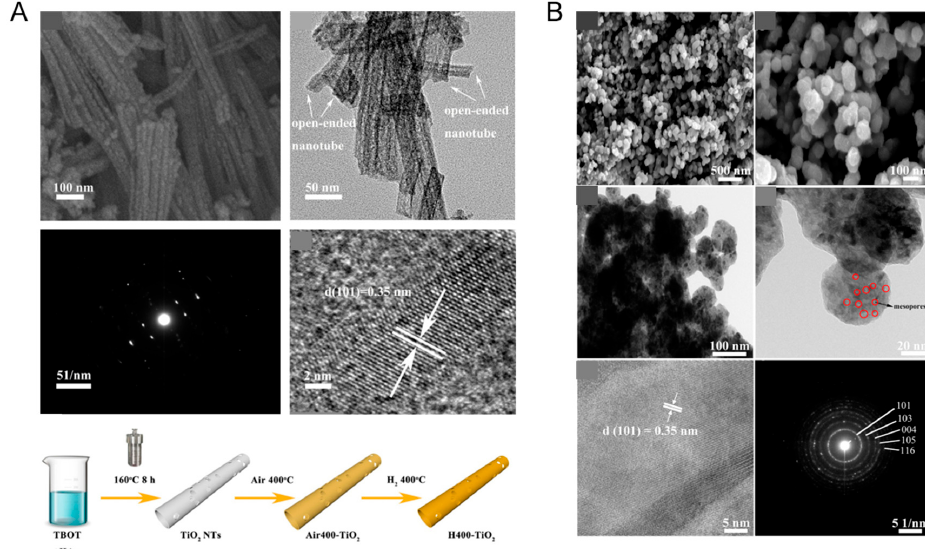
Figure 4. ( A ) SEM, TEM, SAED, HRTEM images and schematic illustration of the formation process of H400-TiO 2 . Reprinted with permission for ref. [80]. Copyright 2021, Elsevier. ( B ) Representative SEM, TEM, HRTEM images and the corresponding elected area electron diffraction (SAED) pattern of the mesoporous TiO 2 nanospheres after surface hydrogenation. Reprinted with permission for ref. [81]. Copyright 2021, Elsevier.